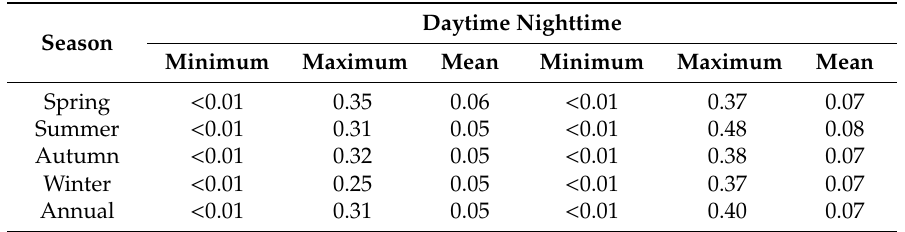
Table 1. The minimum, maximum, and mean of ICF observed from the Cloud-Aerosol Lidar and Infrared Pathfinder Satellite Observation (CALIPSO) during daytime and nighttime in four seasons over the globe between 2007 and